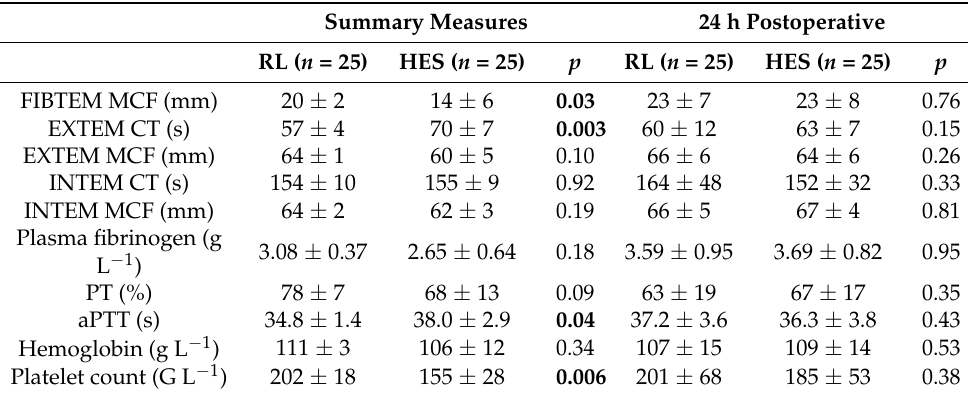
Table 3. Summary measures throughout the entire study period and 24 h postoperative results of ROTEM, conventional coagulation tests, plasma fibrinogen levels, hemoglobin levels, and platelet counts. Values are mean ±